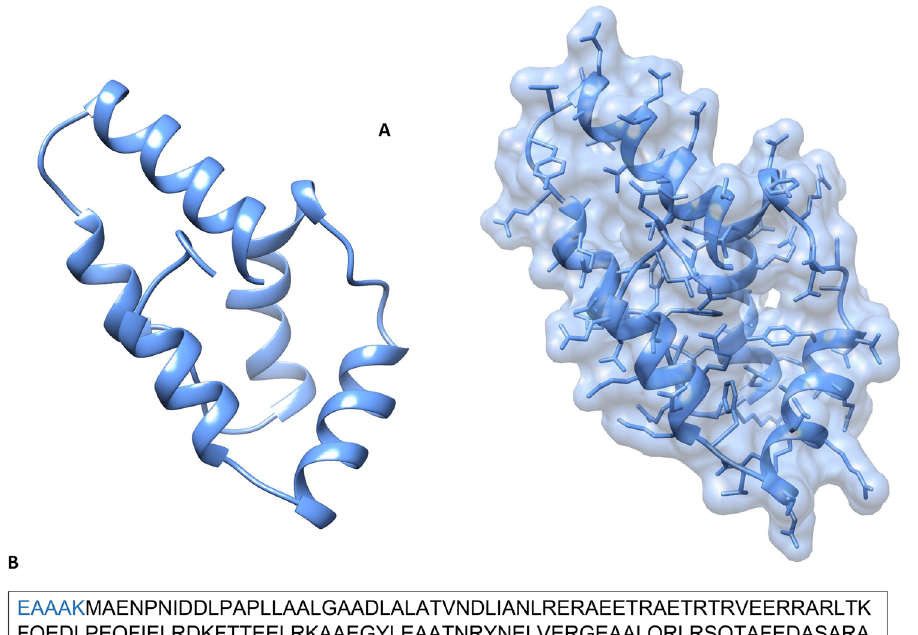
Figure 6. Vaccine structure modeling and Validation. ( A ) The 3D model of a multi-epitope vaccine was obtained by Swiss Model and ( B ) Vaccine sequence.